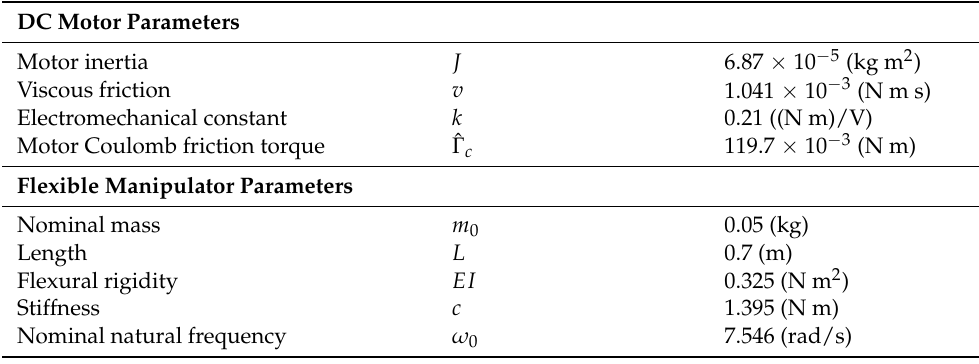
Table 1. The parameters of the single-link flexible manipulator and DC motor.